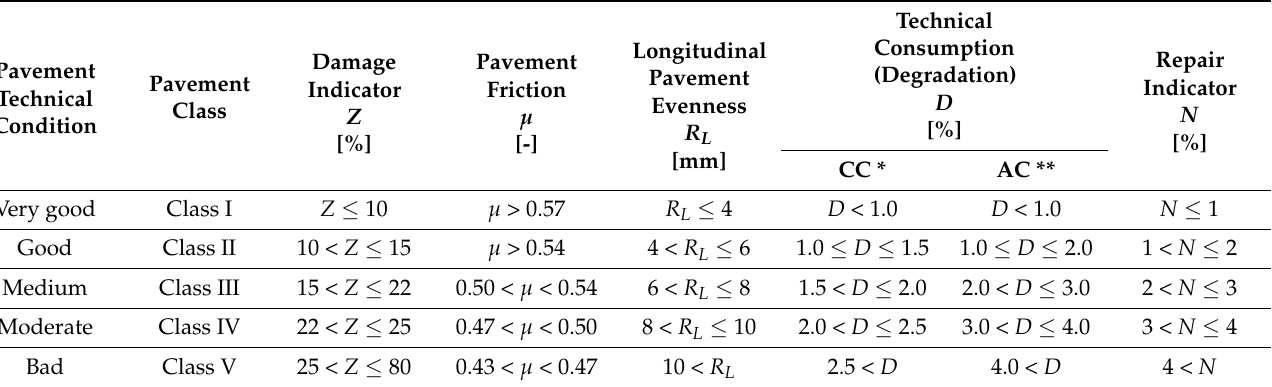
Table 1. A set of parameters qualifying the condition of the airfield’s functional element pavement